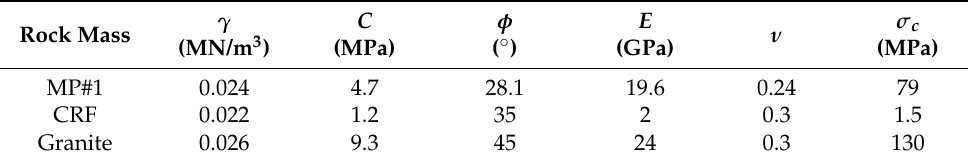
Table 1. Properties applied in the numerical